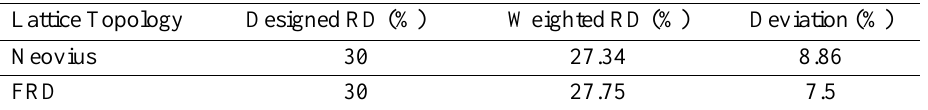
Table 2. The deviation between the designed and measured actual relative density of the printed samples.